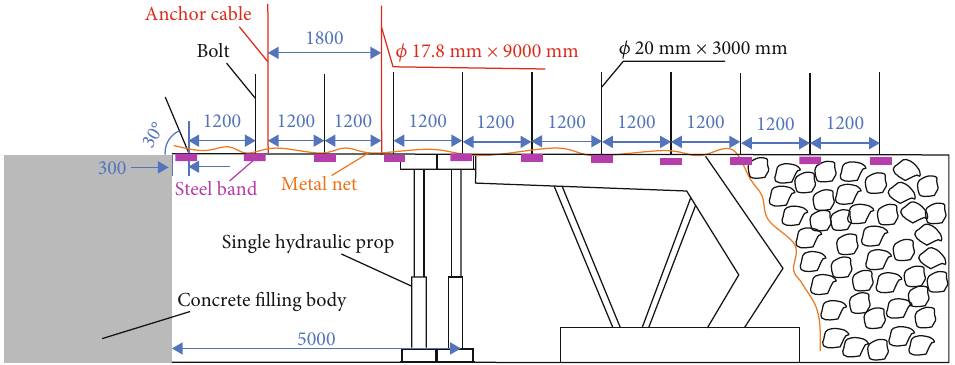
Figure 15: Supporting schematic diagram of retracement channel.